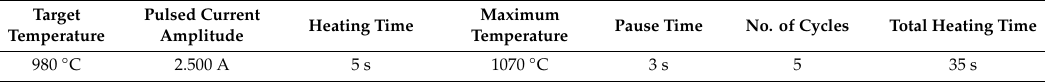
Table 2. Times and temperatures for optimized component heating.